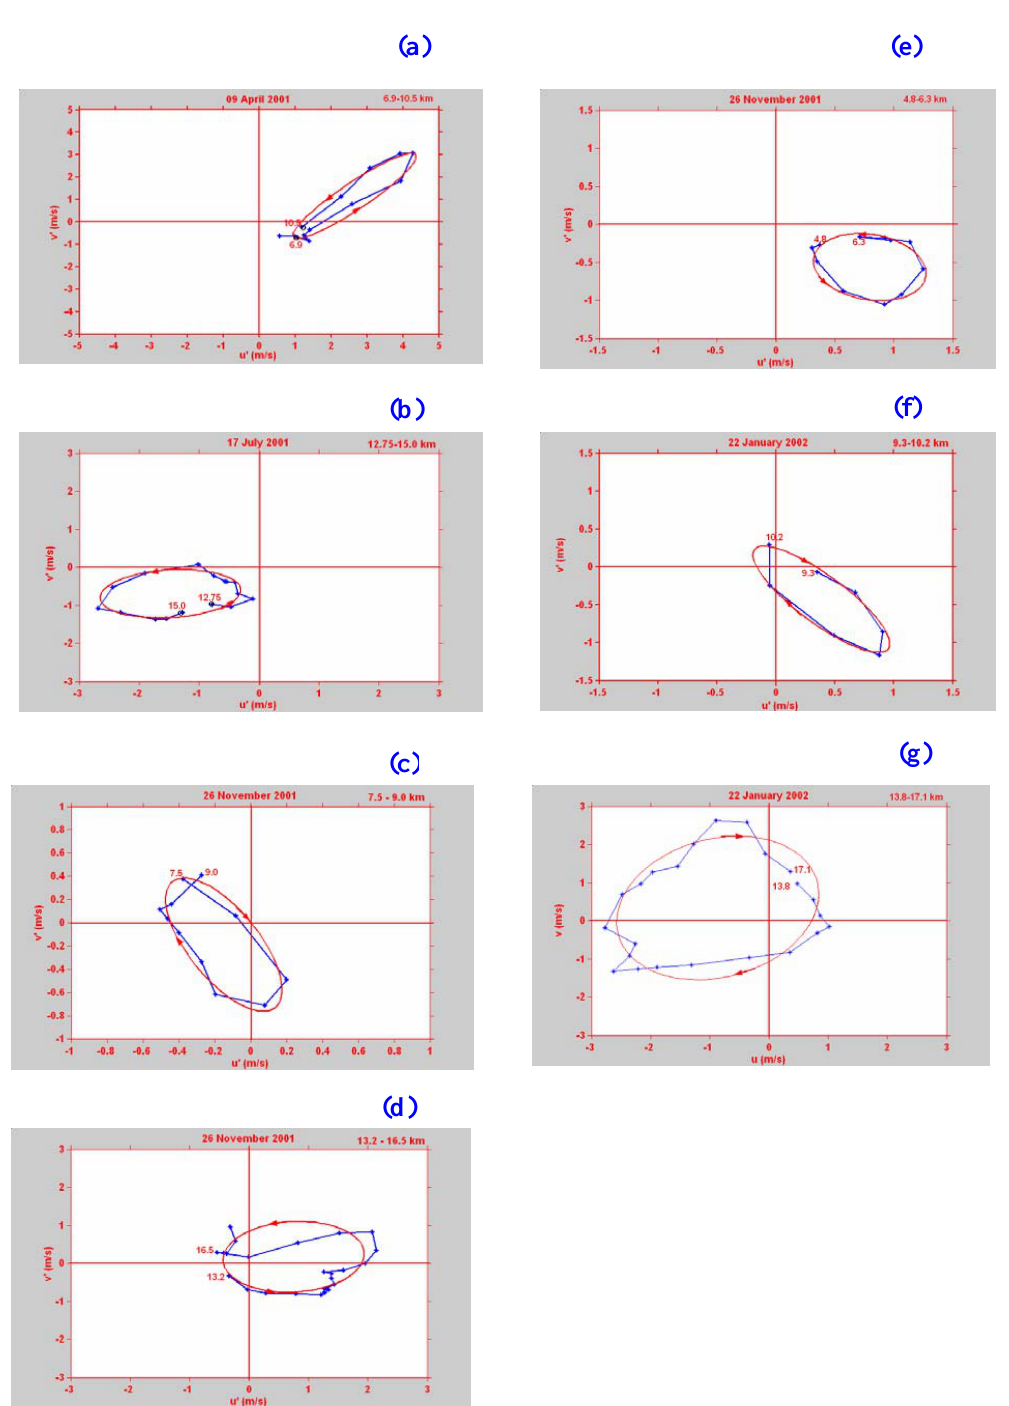
Fig. 12. Hodograph of perturbation velocities, based on mean values over 1h and 300-m increasing height intervals during 10 April 2001 and 150-m increasing height intervals during 17 July 2001, 26 November 2001 and 22 January 2002. The starting and ending heights are marked and the direction of rotation with increasing heights is indicated by arrows. The fitted ellipse to the observed points is shown as a red